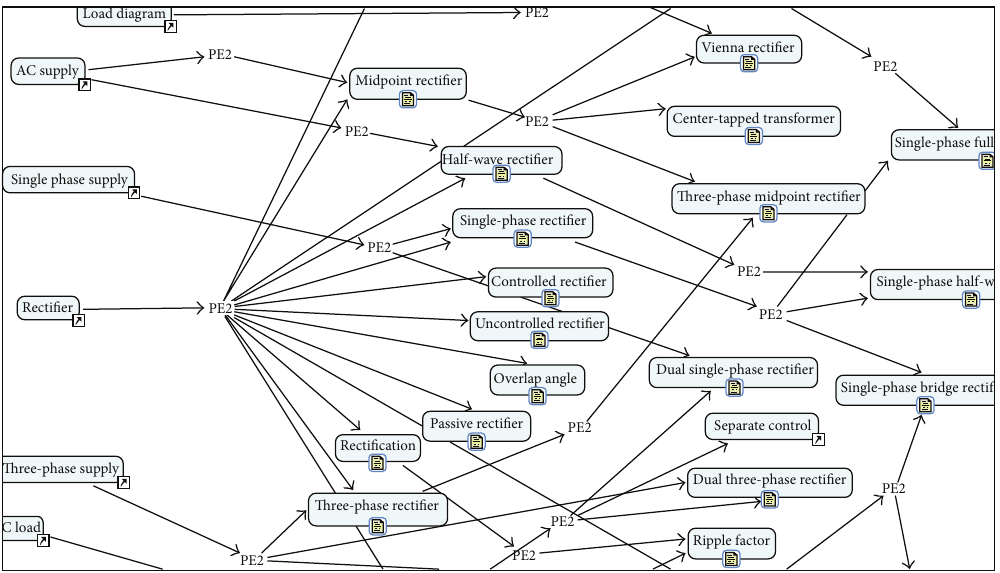
Figure 1: Fragment of concept map in Power